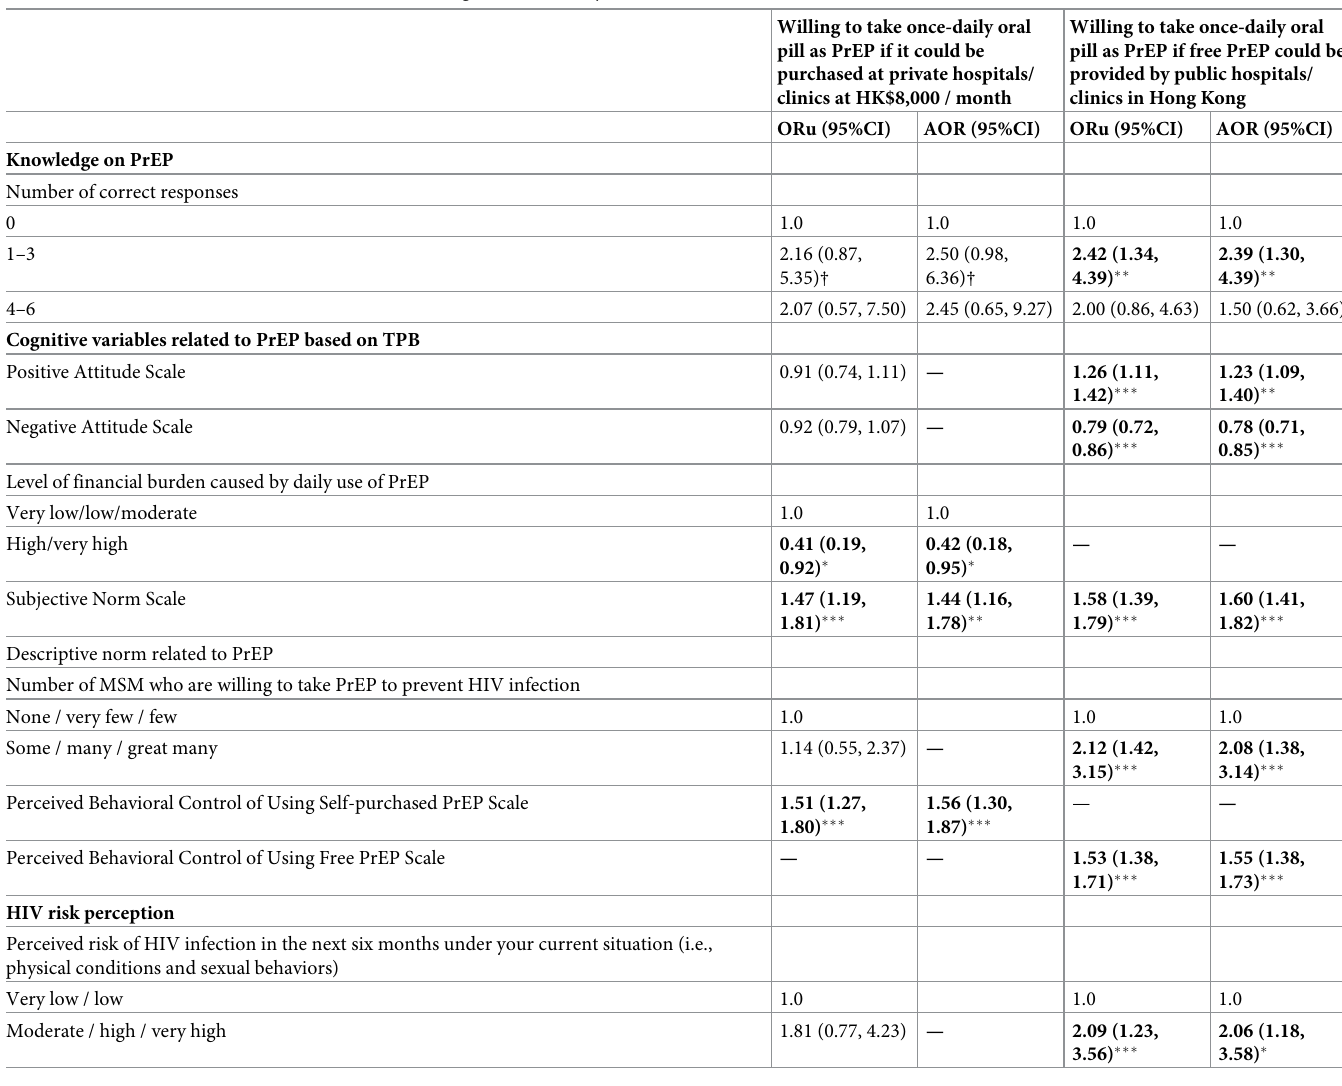
Table 4. Factors associated with two measures of willingness to use daily oral PrEP (n = 403).